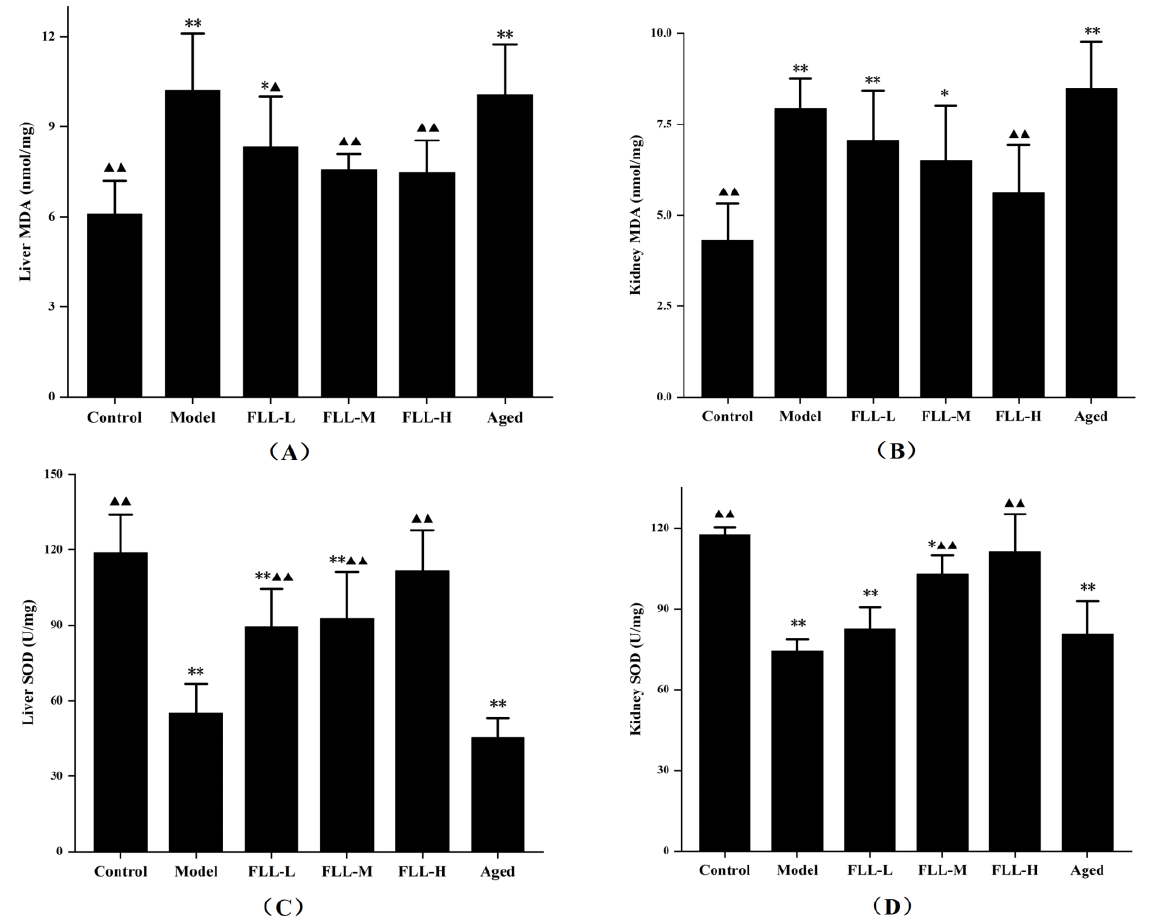
Figure 3. FLL treatment improved the levels of Malondialdehyde (MDA) ( A , B ) and Superoxide Dismutase (SOD) ( C , D ) in the liver and kidney of mice. The 13-week-old Kunming female mice ( n = 8/group) and the 8-month-old aged female mice ( n = 8) were treated with vehicle or FLL water extract at dosages of 1.75, 3.5 and 7 g/kg/d for 20 d. Meanwhile, D-gal injection (10 mg/kg/d) was combined with a low calcium diet (0.1%) to model the osteoporosis induced by oxidative stress in mice. Data are presented as mean ± SD ( n = 8). Compared with the control group, * p < 0.05 and ** p < 0.01. Compared with the model group, ▲ p < 0.05 and ▲▲ p < 0.01.